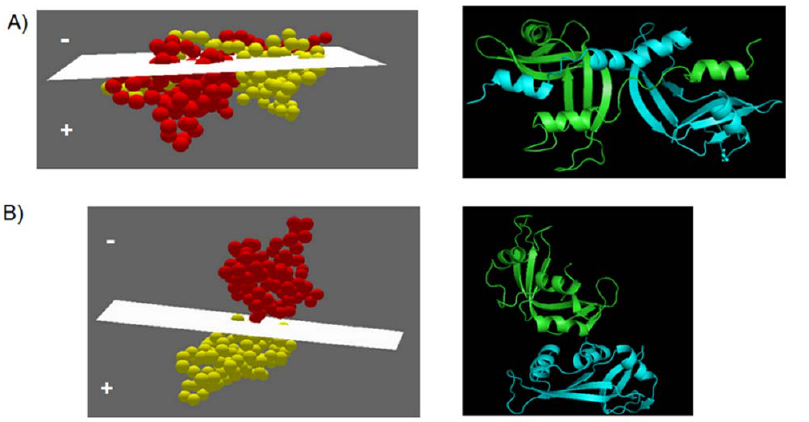
Figure 2. Least Square plane passing through interface residues of domain-swapped form and non-domain-swapped form of ribonuclease. A) Least square plane passing through interface residues of chain A of 1A2W (domain swapped protein). B) Least square plane passing through interface residues of chain A of 1RBB (non-domain-swapped protein and homologue of 1A2W).